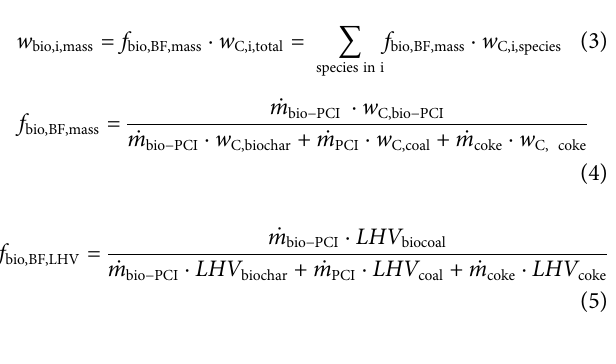
Frontiers in Chemical Engineering |